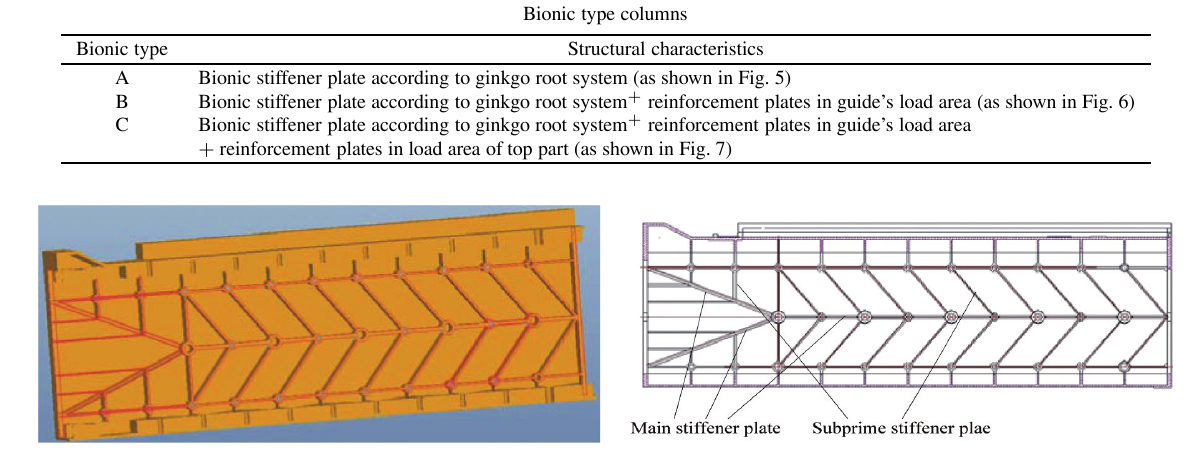
Fig. 5. The bionic type column. (a) Stiffener plate structure of bionic column; (b) 2-D drawing of bionic stiffener plate.